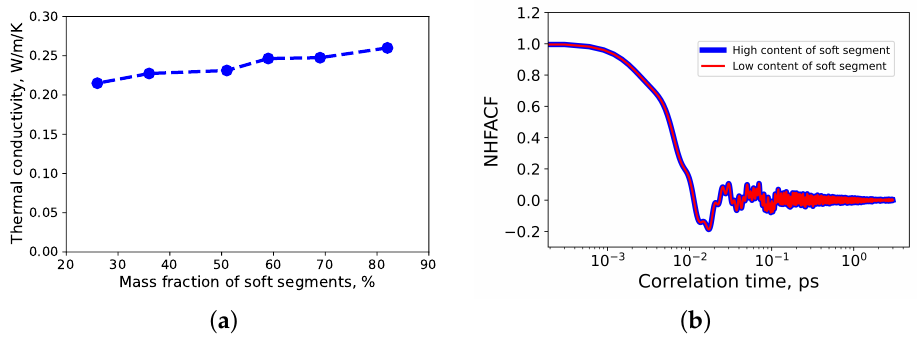
Figure 8. ( a ) The thermal conductivity of TPU as function of mass fraction of soft segments; ( b ) nor- malized heat flux autocorrelation functions (NHFACF) of high content (blue) and low content (red) of thermoplastic